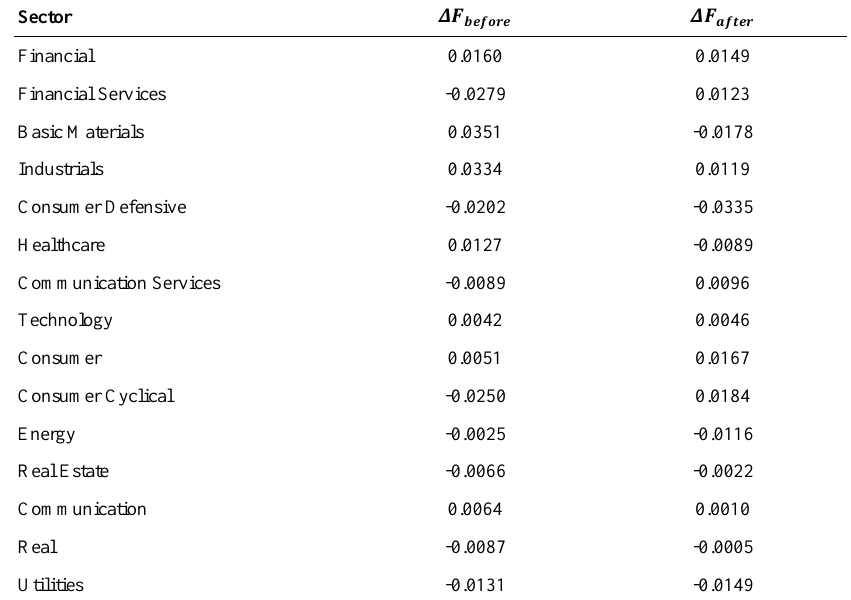
Table 5. The net information outflow for the sectors in FTSE market, before and after COVID-19 outbreak